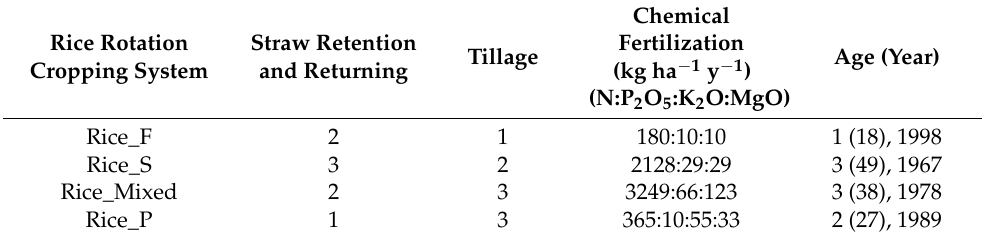
Rice Rotation Crop- Table 2. Summary intensity score of soil management under various rice rotation cropping systems.